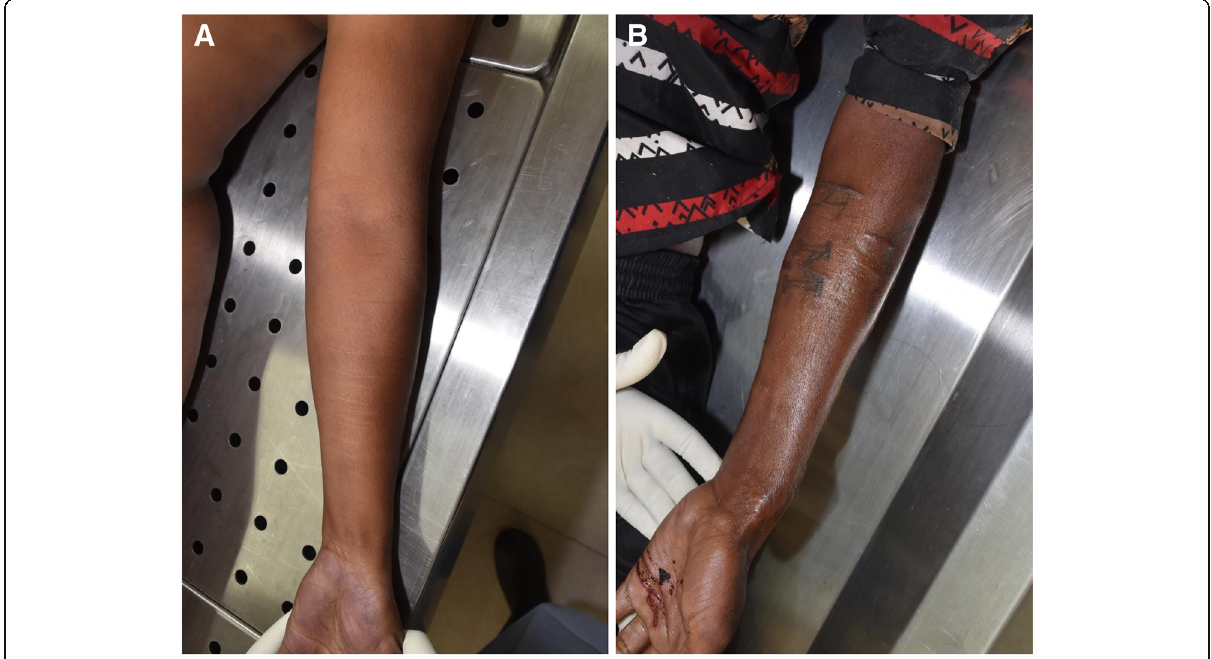
Fig. 3 a , b Multiple old healed linear scars on the ventral aspect of left forearm of both the deceased female and male